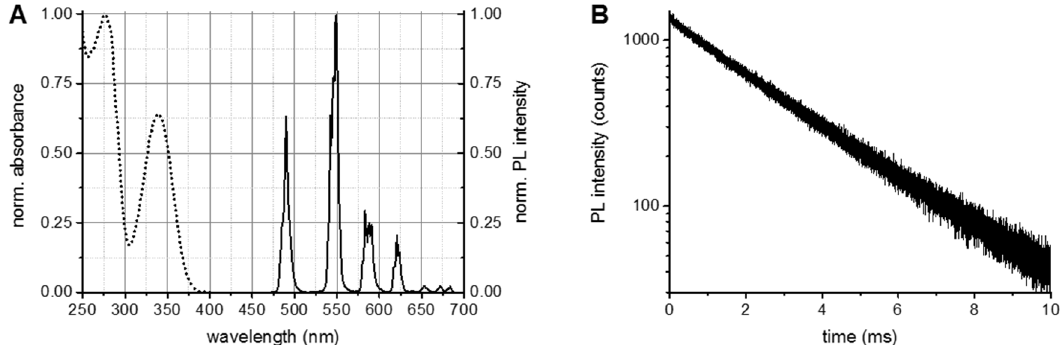
Figure 1. Optical characterizations of Tb-AB conjugates. ( A ) Absorption spectrum (dotted line) of the Tb-AB conjugate, of which the Tb peak at 340 nm and the AB peak at 280 nm were used to calculate the Tb per AB labeling ratio. The PL spectrum (solid line) was acquired upon excitation in the Tb absorption band (365 ± 2 nm); ( B ) Pulsed (Xe flash lamp at 100 Hz) excitation (360 ± 2 nm) was used to measure the PL decay at 490.0 ± 0.5 nm. The slightly bi-exponential decay curve ( τ 1 = 0.4 ± 0.3 ms, τ 2 = 2.70 ± 0.02 ms) gave an amplitude-averaged decay time of τ (Tb) = 2.6 ± 0.2 ms.